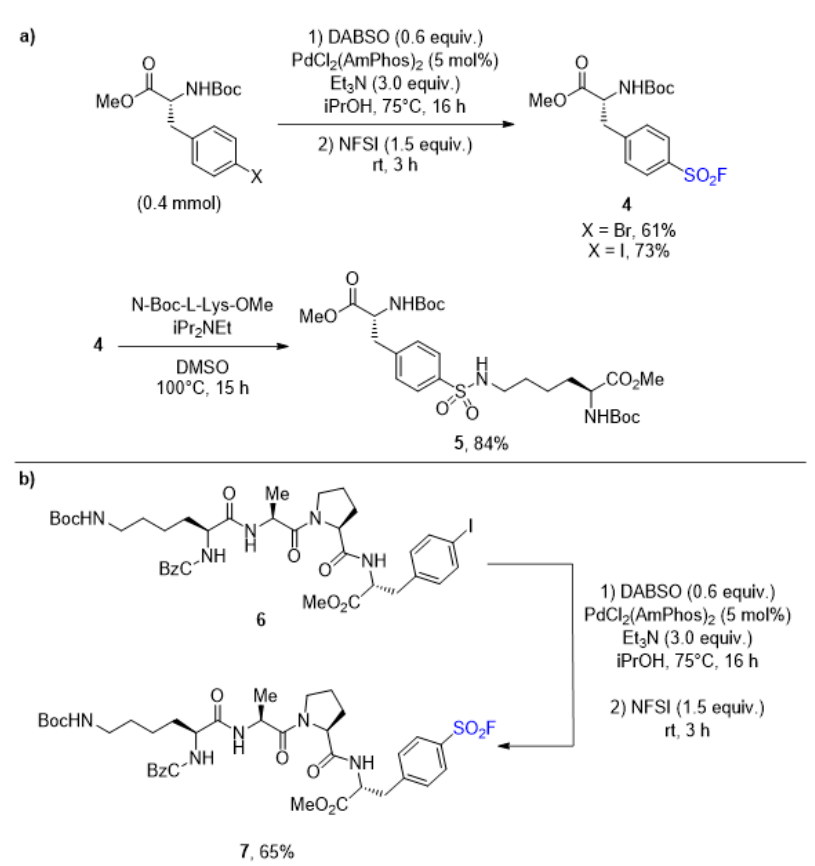
Scheme 3. Synthesis of amino acid and peptidic sulfonyl fluorides.